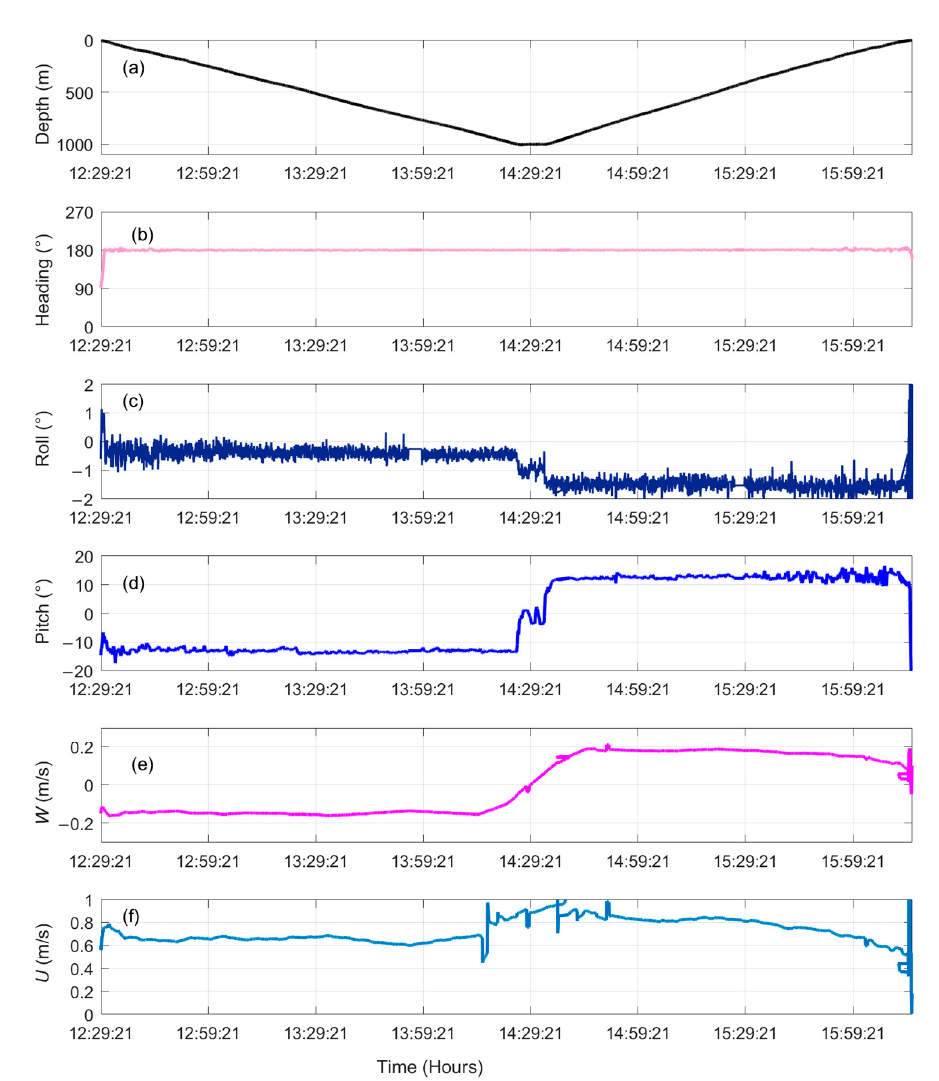
Figure 13. Time series of the turbulence AUV flight performance on 13 September 2020: ( a ) depth,